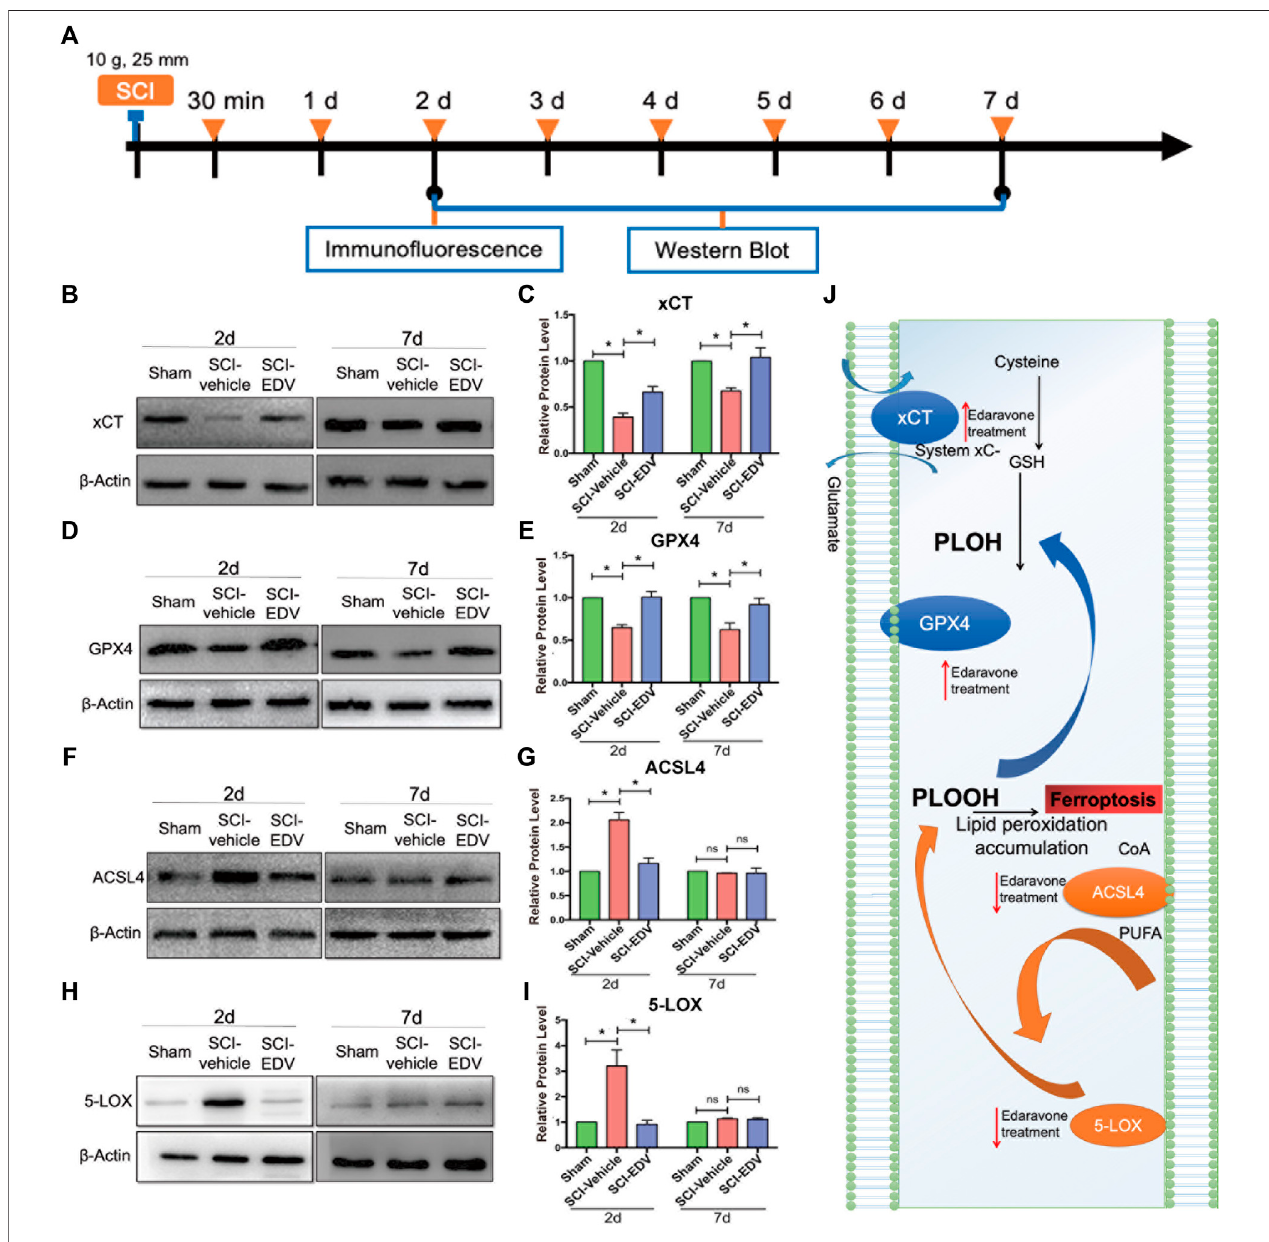
FIGURE 1 | Edaravone modulates key proteins of the ferroptosis pathway in the spinal cord. (A) Schematic diagram of the experimental timeline. Wistar rats were intraperitoneally injected with 5 mg/kg edaravone daily during the fi rst 7 days. At 2 and 7 days post SCI, tissues from spinal cord lesion epicenter were collected for western blot. At 2 days post injury the lesion epicenter and caudal spinal cord were observed from the immuno fl uorescence. (B,D,F,H) Representative western blot images of xCT (B) , GPX4 (D) , ACSL4 (F) and 5-LOX (H) . (C,E,G,I) Quanti fi cations of three western blot band of xCT (C) , GPX4 (E) , ACSL4 (G) and 5-LOX (I) . Experiments were repeated three times. Data are expressed as mean ± standard deviation. Statistical signi fi cance was determined by one-way ANOVA with Tukey ’ s post hoc test. * p < 0.05, n = 3. (J) Diagram depicts that the ferroptosis pathway of SCI is modulated by edaravone.